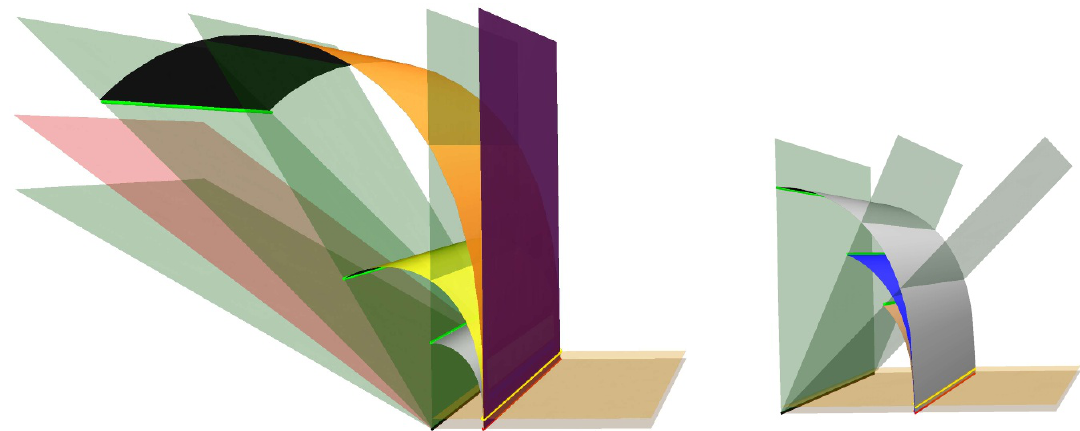
Figure 2 . Minimal area surfaces corresponding to the same in(cid:12)nite strip A in the z = 0 half plane (the grey half plane) which is adjacent to the boundary x = 0 (straight solid black line). The entangling curve is the straight solid red line. The yellow horizontal plane is given by z = " . The green half planes correspond to Q in (2.20) for di(cid:11)erent values of (cid:11) and the red half plane is Q with (cid:11) = (cid:11) c . For (cid:11) > (cid:11) c we show ^ (cid:13) con and @ ^ (cid:13) Q = ^ (cid:13) con \ Q are highlighted (green straight lines). The A A vertical purple half plane corresponds to ^ (cid:13) dis . In the left panel 0 < (cid:11) 6 (cid:25)= 2 and in the right panel A (cid:25)= 2 6 (cid:11) < (cid:25)